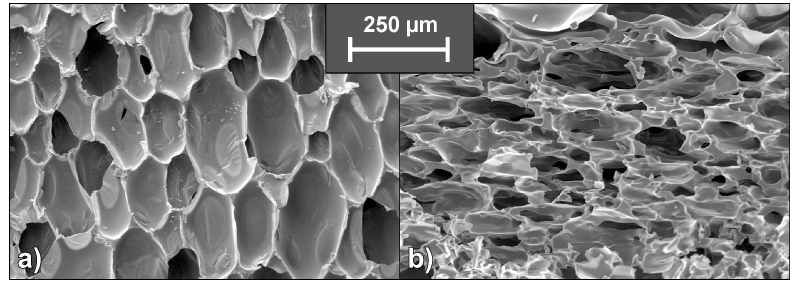
Figure 13. SEM micrographs of PIR-70-P, structure of the ( a ) foam and ( b ) residues.